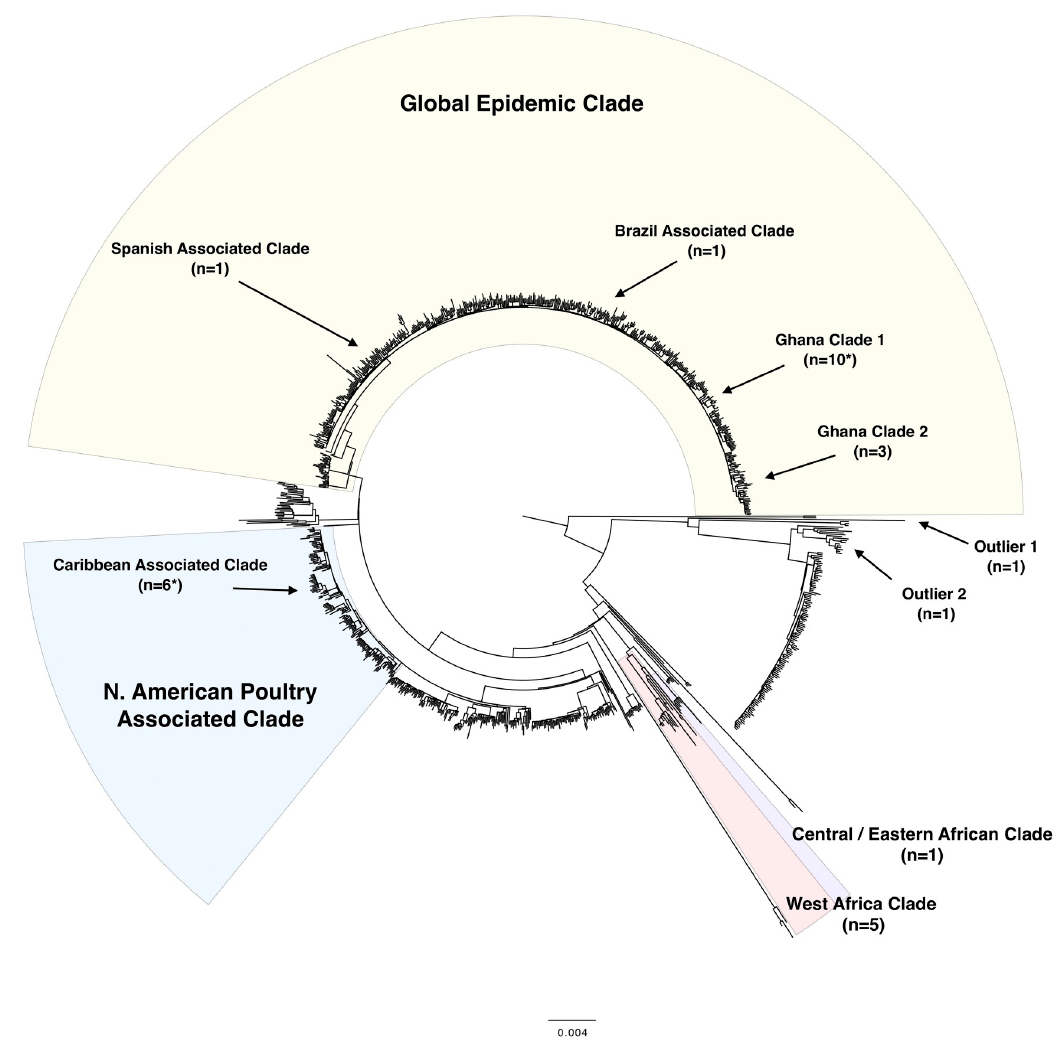
Fig 1. Midpoint-rooted maximum likelihood phylogeny of S . Enteritidis based on 1067 Public Health England surveillance isolates and the 29 Ghanaian isolates. The majority of the Ghanaian isolates fall into four major clades (a global epidemic clade, a second global clade containing a lineage associated with North American poultry, a Central/ East African clade and a West African clade). Within the global epidemic clade the Ghanaian isolates cluster into sub-clades. Numbers of Ghanaian isolates in each clade or sub-clade are noted in brackets (n =). An asterisk represents clades containing the poultry isolates ( � ). All clades are supported by bifurcating nodes with 100% bootstrap support. The scale bar shows nucleotide substitutions per site.